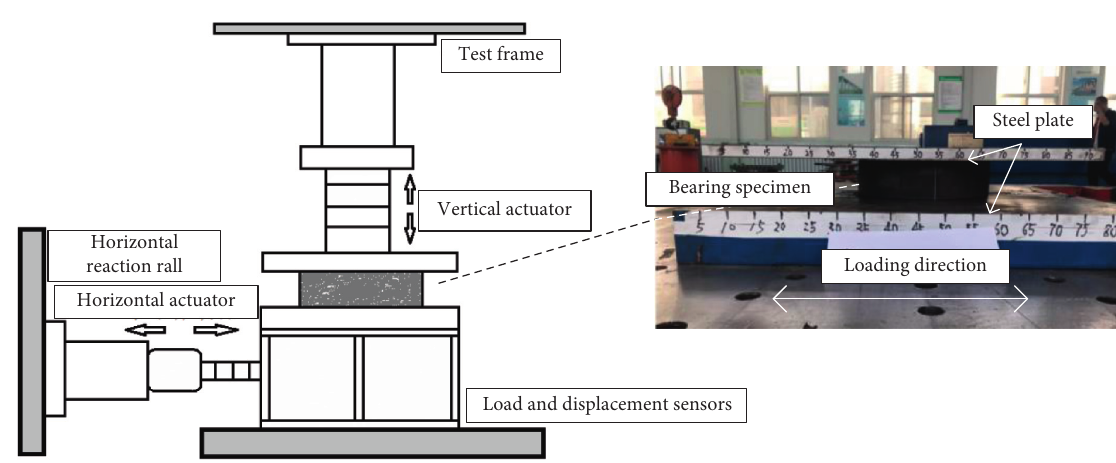
Figure 3: Testing setup.